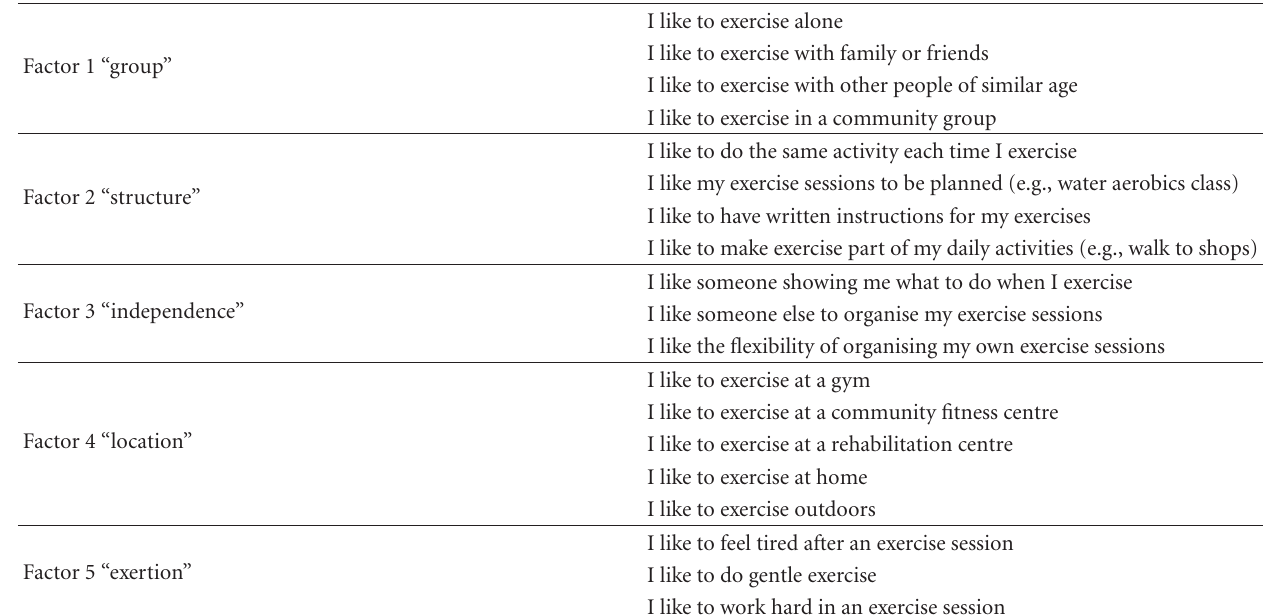
Table 1: A priori exercise preference